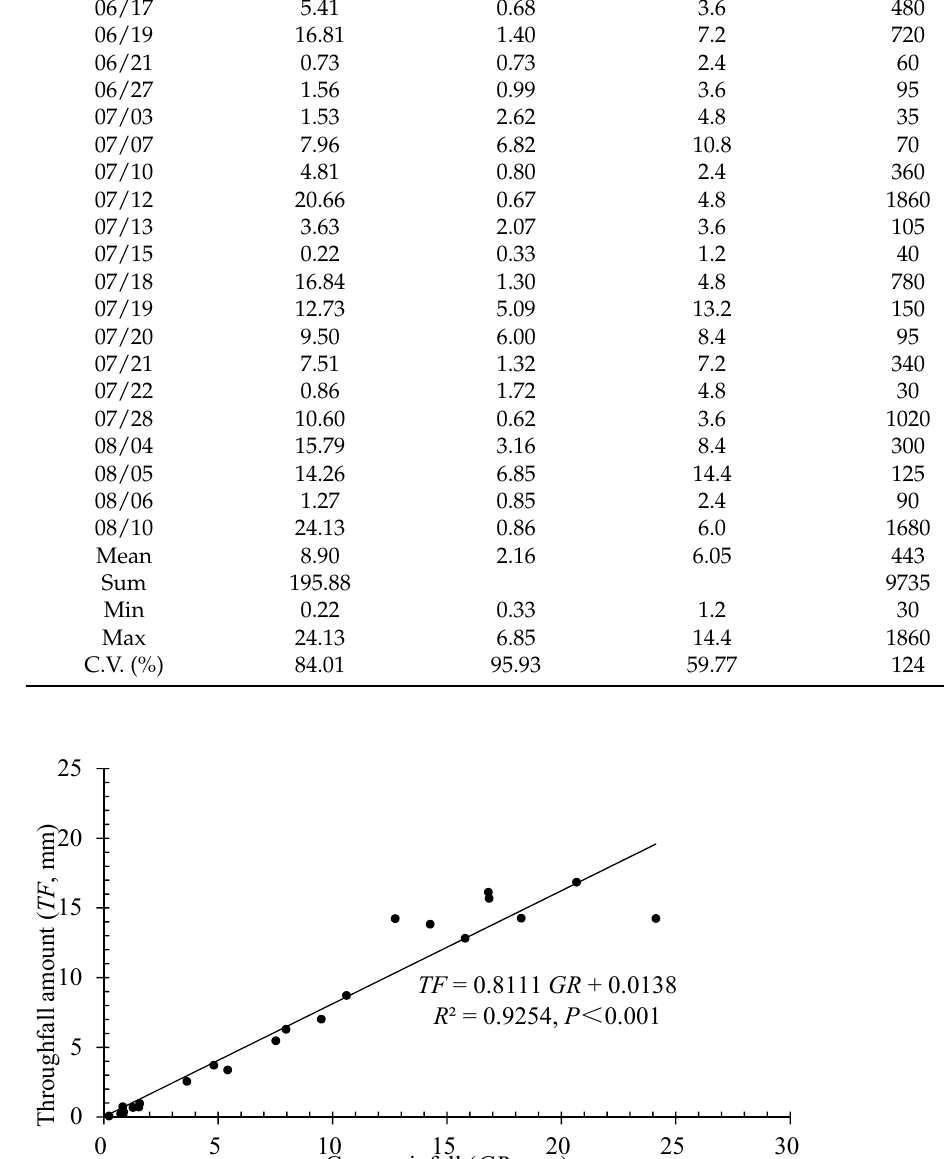
TF = 0.8111 GR + 0.0138 R ² = 0.9254, P ＜ 0.001